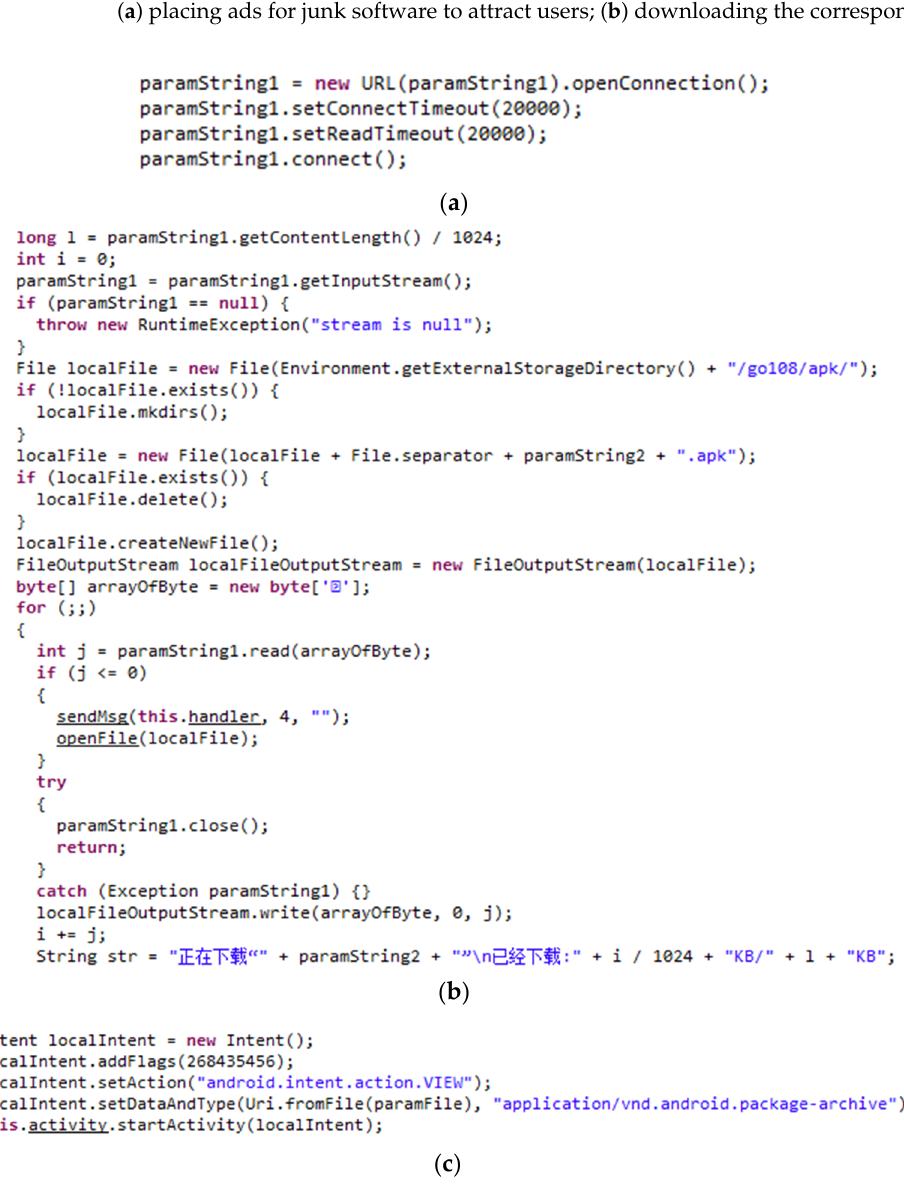
Figure 10. Implementation code for software download and installation: ( a ) opening internet connection in the doDownloadTheFile method; ( b ) tracking download progress in the doDownloadTheFile method; ( c ) installing a package in the openFile method.